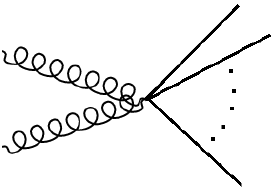
Figure 3 . A diagram with two spin 2 particles and an arbitrary number of matter particles, of the type studied in this